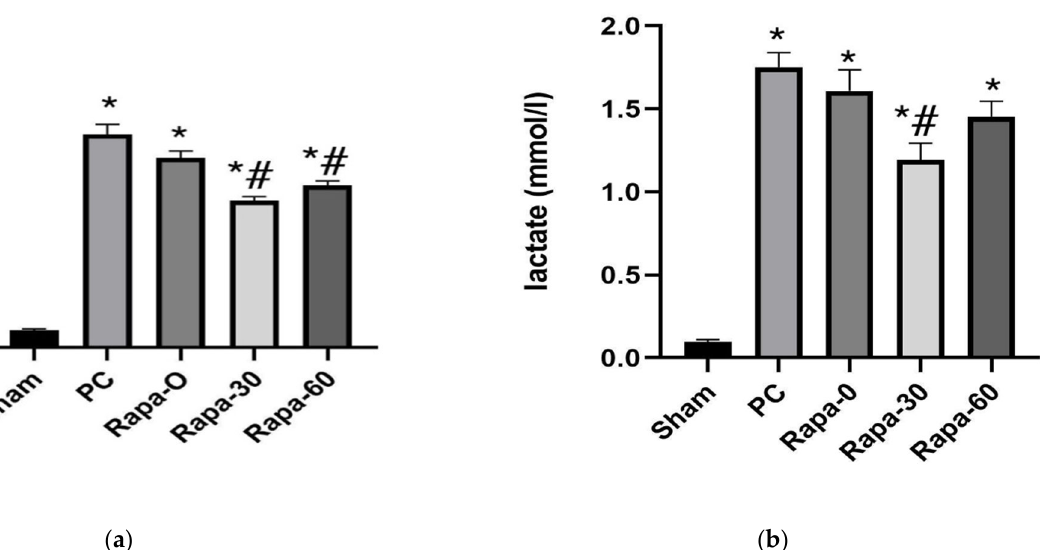
Figure 2. Graphical representation of changes in LDH ( a ) and lactate ( b ) after cold preservation. Data are mean ± SEM. N = 6. * p < 0.0001 vs. sham. # p < 0.05 versus PC group.